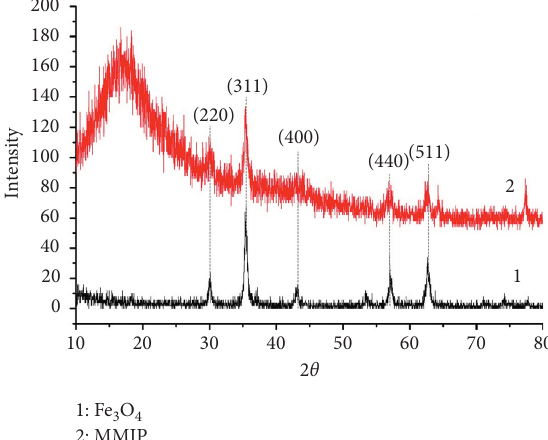
Figure 3: XRD patterns of the Fe